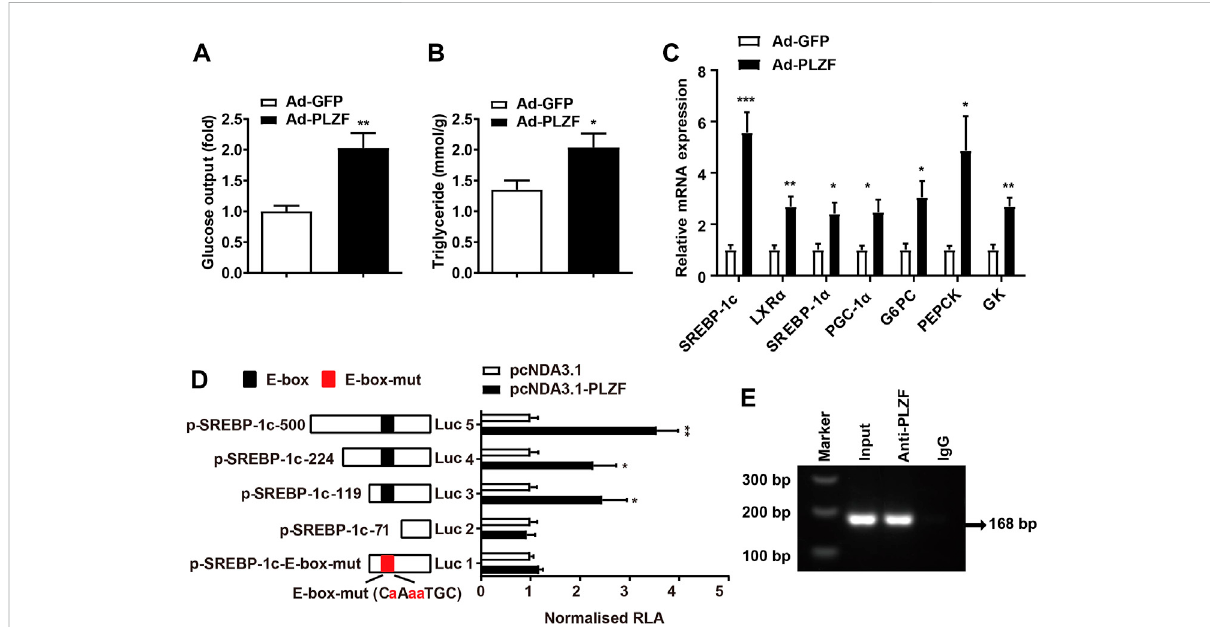
FIGURE 3 PLZF stimulates transcription of the SREBP-1c gene by directly binding to its promoter. (A) Glucose production and (B) TG levels in the primary hepatocytes treated with the indicated adenovirus. (C) qPCR analysis of glucogenic genes and lipogenic genes in the primary hepatocytes treated with the indicated adenovirus. (D) Luciferase reporter gene assay in HepG2 cells transfected with the indicated plasmids. A number of truncated SREBP-1c promotersthatwerefusedtotheluciferasereportergenewereco-transfectedwithpcDNA3.1orpcDNA3.1-PLZFplasmidintoHepG2cells. (E)